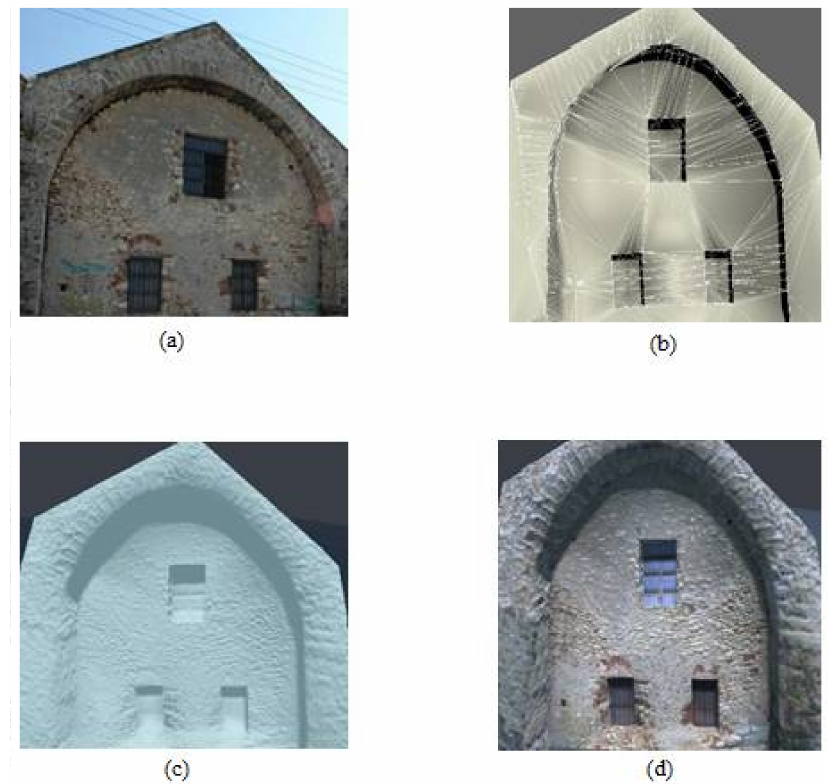
Figure 8. The final 3D model stages for the Neoria building front façade: ( a ) initial building image; ( b ) the 3D model with the addition of inner building protrusion information; ( c ) enriched model via normal mapping; and ( d ) the final 3D reconstruction after texture addition through image sampling.